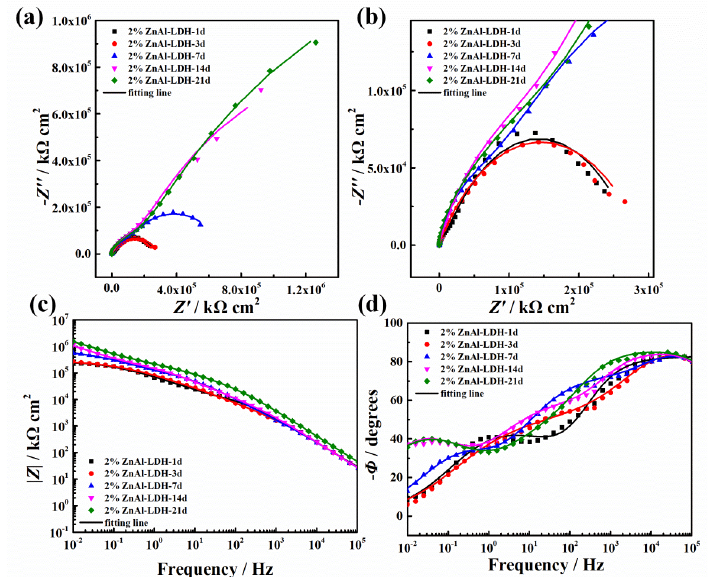
Figure 15. The Nyquist and Bode plots of the epoxy coating with addition of 2% ZnAl-LDH during an immersion of 21 d. ( a ) Nyquist plots; ( b ) magnification of Nyquist plots at high frequencies; ( c ) Impedance-frequency Bode plots; ( d ) Phase-frequency Bode plots. Figure 16 shows the EIS results of the epoxy coating with addition of 2% CaAl-LDH during an immersion of 21 d. It can be seen from Figure 16a,b that the impedance arc and the impedance values at low frequencies remained almost constant during an immersion period of 1 d to 7 d. With time going on, the impedance arc became larger and the imped- ance value at low frequencies reached 1.8 × 10 7 kΩ cm 2 after immersion for 21 d, which is more than one magnitude higher than that of the blank epoxy coating, demonstrating su- perior corrosion protection ability of CaAl-LDH. Although it seems that there was only one phase angle peak in Figure 16c, the presence of this broad peak was possibly due to the overlapping of two separate phase angle peaks, where one corresponded to the epoxy coatings and the other was related to the corrosion process. Similar to the blank epoxy coating, the equivalent circuit with two-time constants in Figure 17a was adopted to fit the EIS data, where one time constant was related to the coating, and the other corre- sponded to the charge transfer process in the coating/substrate interface, respectively.